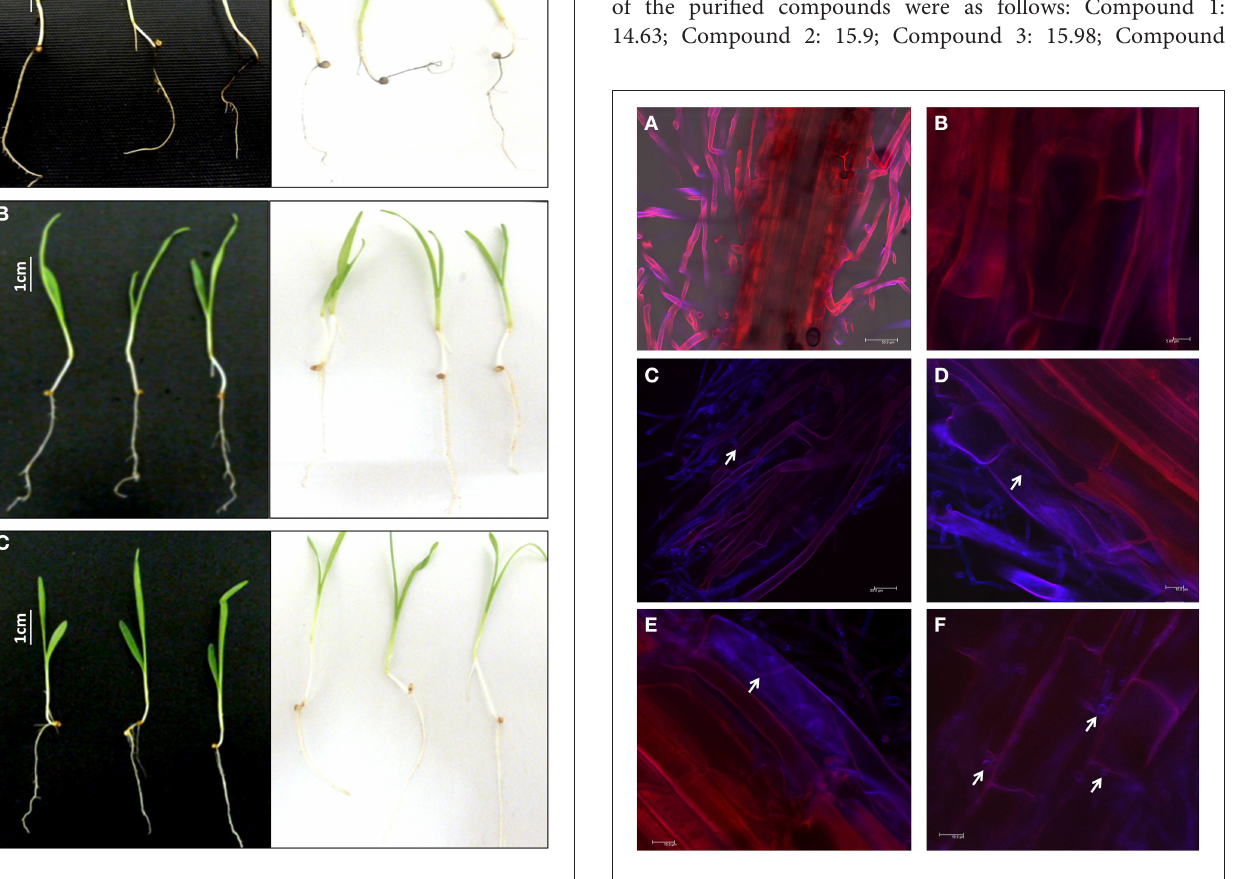
FIGURE 3 | Root colonization study using confocal scanning laser microscopy. (A,B) Representative pictures of root tissues inoculated with the buffer control. (C–F) Representative pictures of root tissues inoculated with WF4. WF4 fluoresces purple-blue due to staining with Calcofluor. Plant tissues appear red due to autofluorescence. White arrows point to WF4 inside the plant